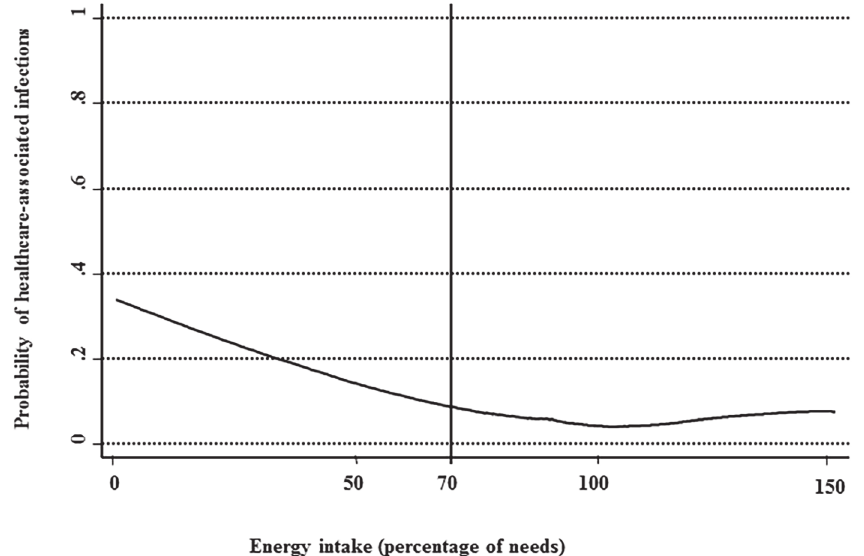
Fig 3. Probability of healthcare-associated infections according to the measured energy intake (expressed as % of predicted energy needs. Predicted energy needs are calculated as 110% of the Harris- Benedict formula. The Fig 3 shows that the probability of healthcare-associated infection is high when measured energy intake is (cid:3) 70% of predicted energy needs according to the locally weighted scatterplot smoothing graphical procedure.